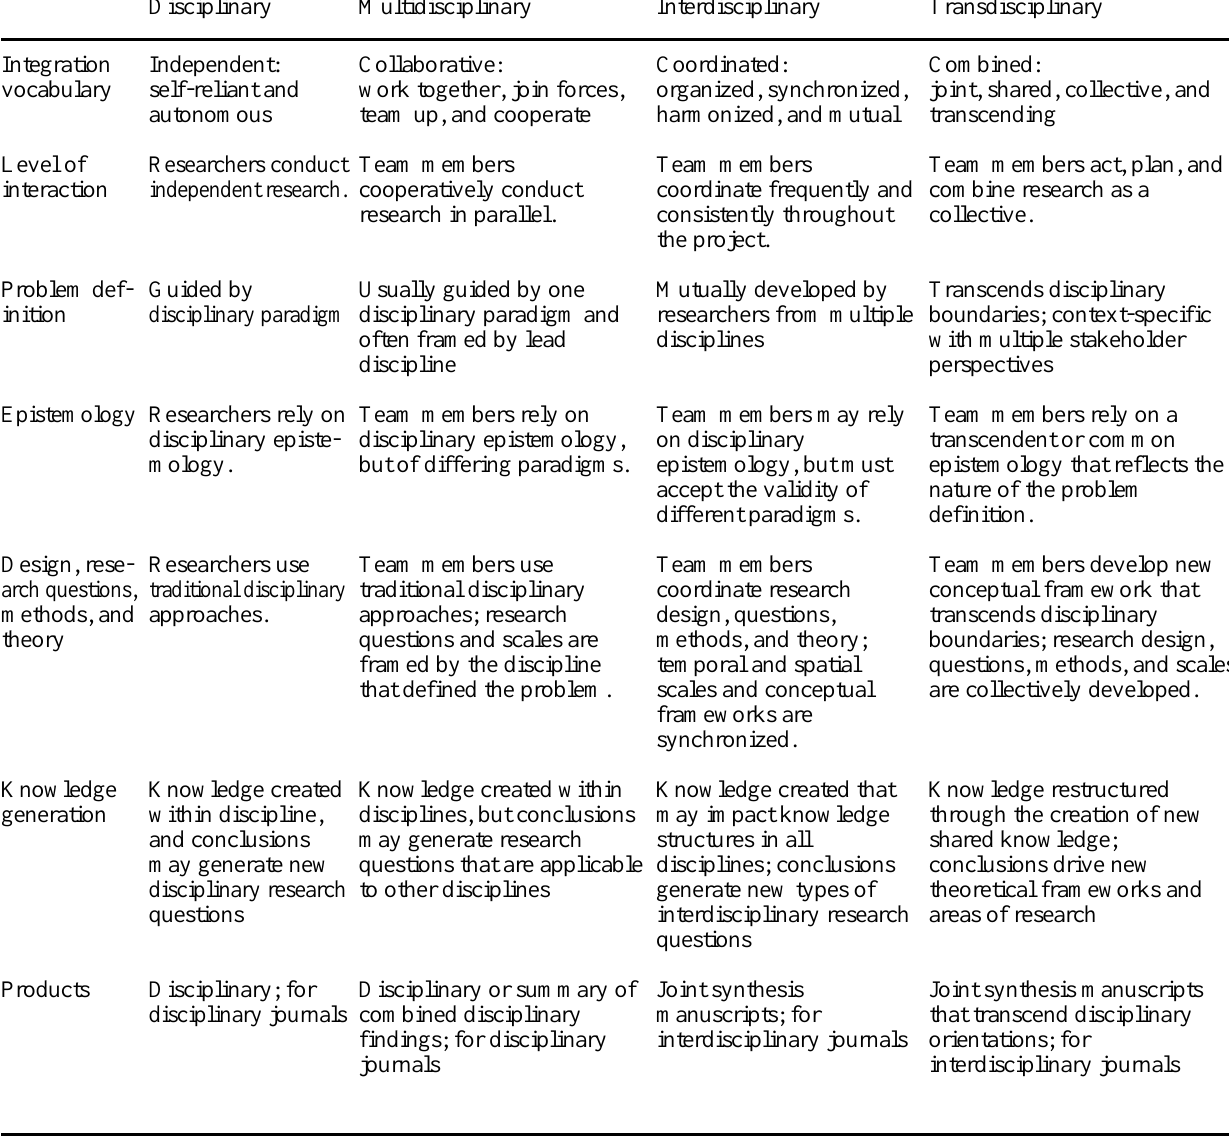
Table 1 . Spectrum of disciplinary integration in scientific research based on the literature